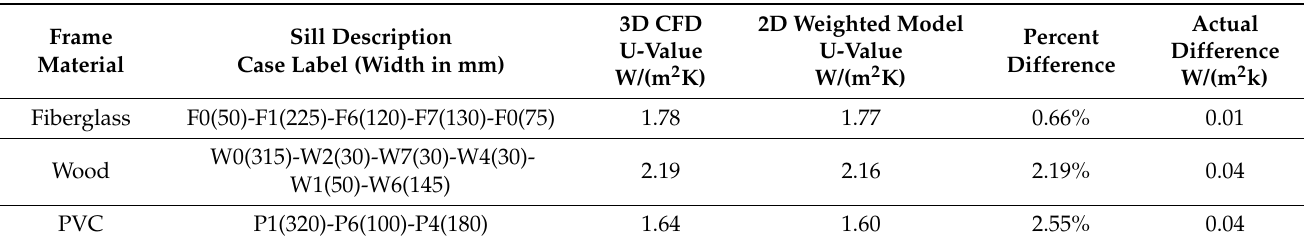
Table 3. Comparison of U-values for frames with variable hardware shapes obtained from 3D simulation and 2D simulation weighted by the developed model.